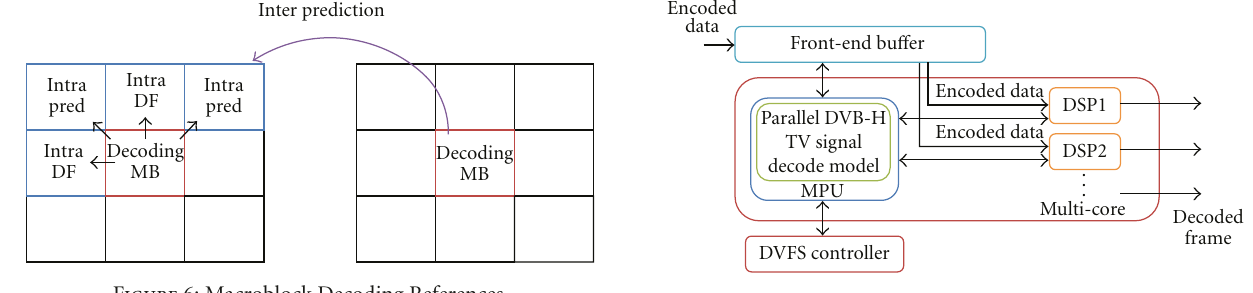
Figure 7: System